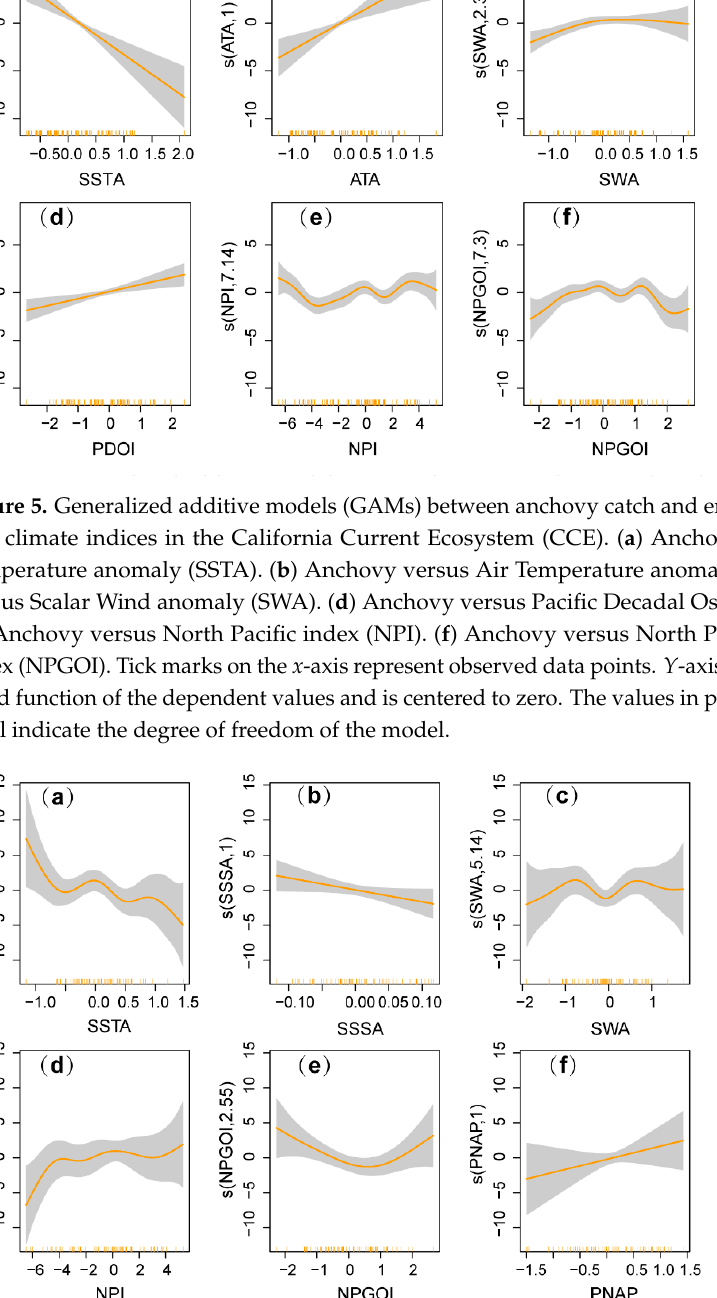
Figure 6. Generalized additive models (GAMs) between anchovy catch and environmental variables and climate indices in the Humboldt Current Ecosystem (HCE). ( a ) Anchovy versus Sea Surface Temperature Anomaly (SSTA). ( b ) Anchovy versus Sea Surface Salinity Anomaly (SSSA). ( c ) Anchovy versus Scalar Wind anomaly (SWA). ( d ) Anchovy versus North Pacific index (NPI). ( e ) Anchovy versus North Pacific Gyre Oscillation index (NPGOI). ( f ) Anchovy versus Pacific/North American Pattern (PNAP). Tick marks on the x -axis represent observed data points. Y -axis represents the smooth fitted function of the dependent values and is centered to zero. The values in parentheses in the y -axis label indicate the degree of freedom of the